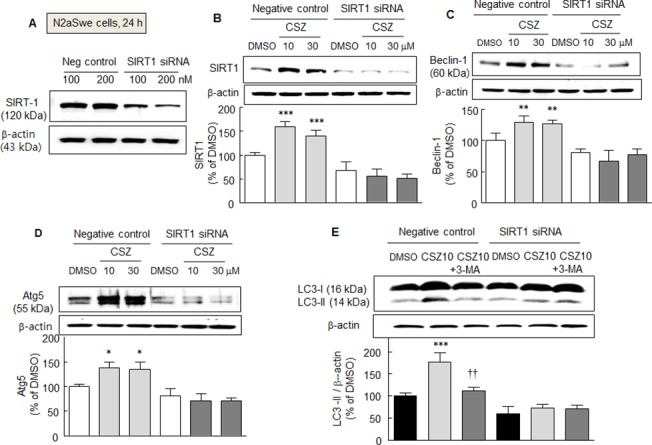
A. Analysis of the effects of SIRT1-knockdown in N2aSwe cells. Proteins (30 μg) from a negative control and SIRT1- knockdown samples were loaded onto 10 ~ 15% SDS-polyacrylamide gels. In N2aSwe cells transfected with 200 nM of SIRT1 siRNA, SIRT1 protein levels were at ~ 40% of the level in negative controls (A). Cilostazol failed to elevate the expressions of SIRT1 (B), beclin1 (C), Atg5 (D), and (E) LC3 in SIRT1-siRNA treated N2a cells, as contrasted to the levels of all four in the negative control cells.Results are the means ± SDs of 4 experiments. *P < 0.05, **P < 0.01, ***P < 0.001 vs. DMSO. ††
P < 0.01 vs. cilostazol alone (CSZ, 10 μM).